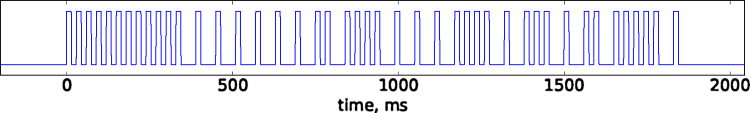
One timestamp as recorded on the trigger channel of the MEG device. Individual bits of the timestamp are encoded as delays between subsequent pulses.